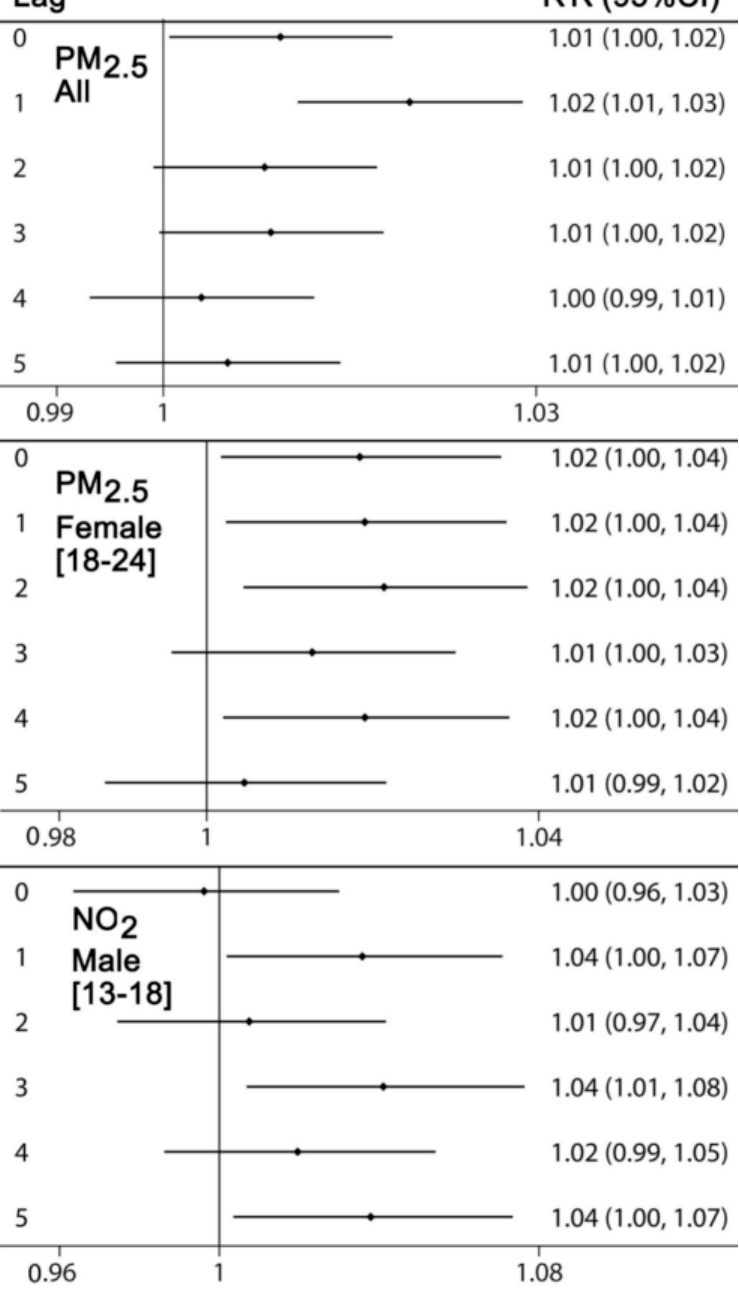
Figure 2. Relative risks (RR) and their 95% confidence intervals (CI) for fine particulate matter (PM 2.5 ) (all patients and female individuals of age 19 to 24 years) and NO 2 (male individuals of age 13 to 18 years). Lags are in days. Toronto, Canada, 2004–2015.